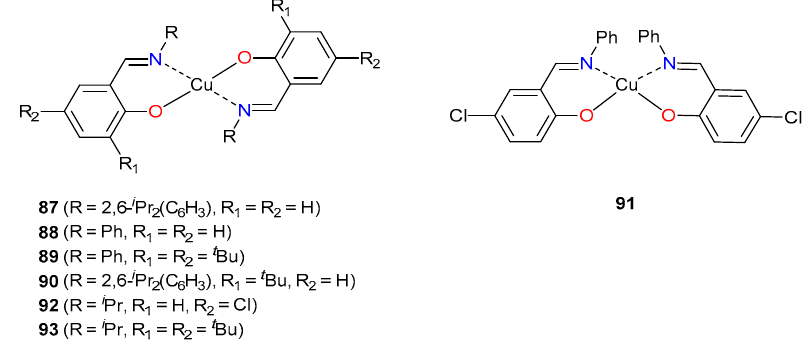
Figure 15. Cu II complexes 87–93 [62].